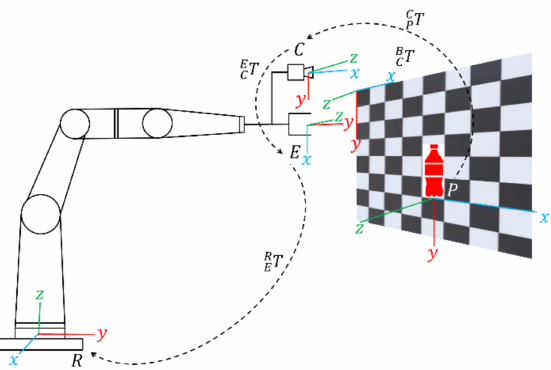
Figure 10. Eye-in-hand robot manipulator frame in an offline shop. The transformation begins from target in shelf coordinate frame P to camera coordinate frame C , then transforms from C to coordinate frame E , and continues to transform frame R as robot